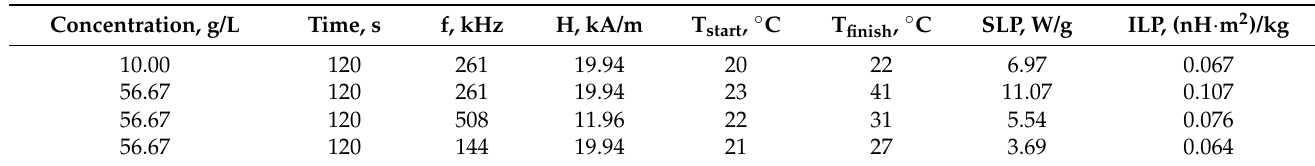
Table 5. Magnetic hyperthermia of the SrFe 12 − x In x O 19 sample C4 (x = 1.7), obtained by the citrate method and annealed at 1200 ◦ C for 1